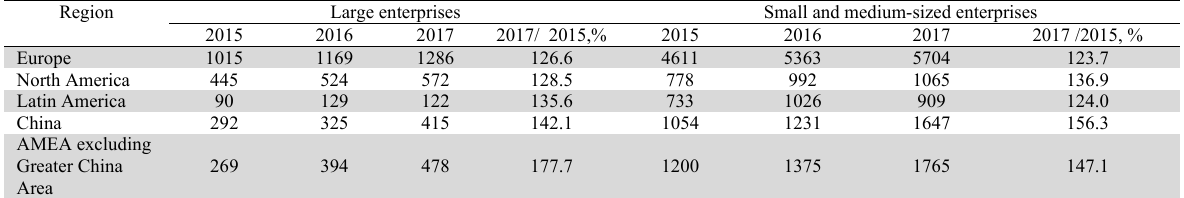
Region Large enterprises